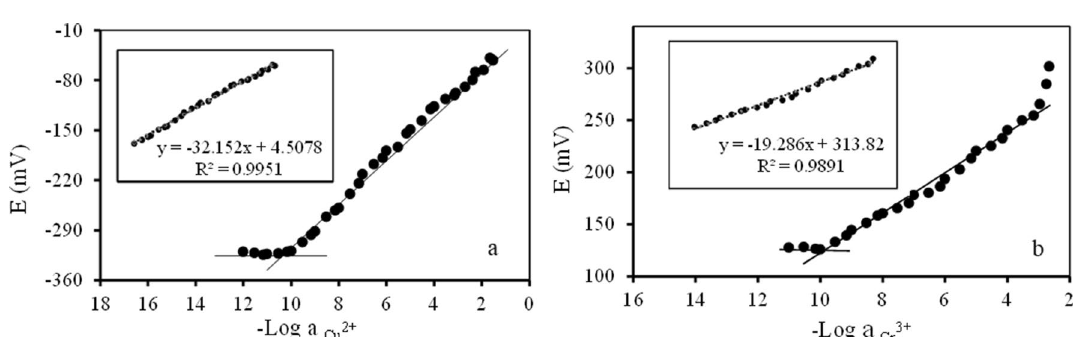
Figure 5. Calibrations curves of ( a ) copper (II) and ( b ) chromium (III) selective